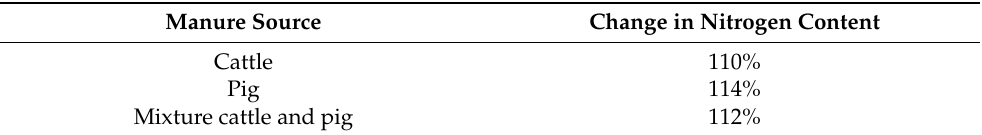
Table 2. Change in nitrogen content in animal manure that are due to acidification relative to untreated manure slurry in the baseline